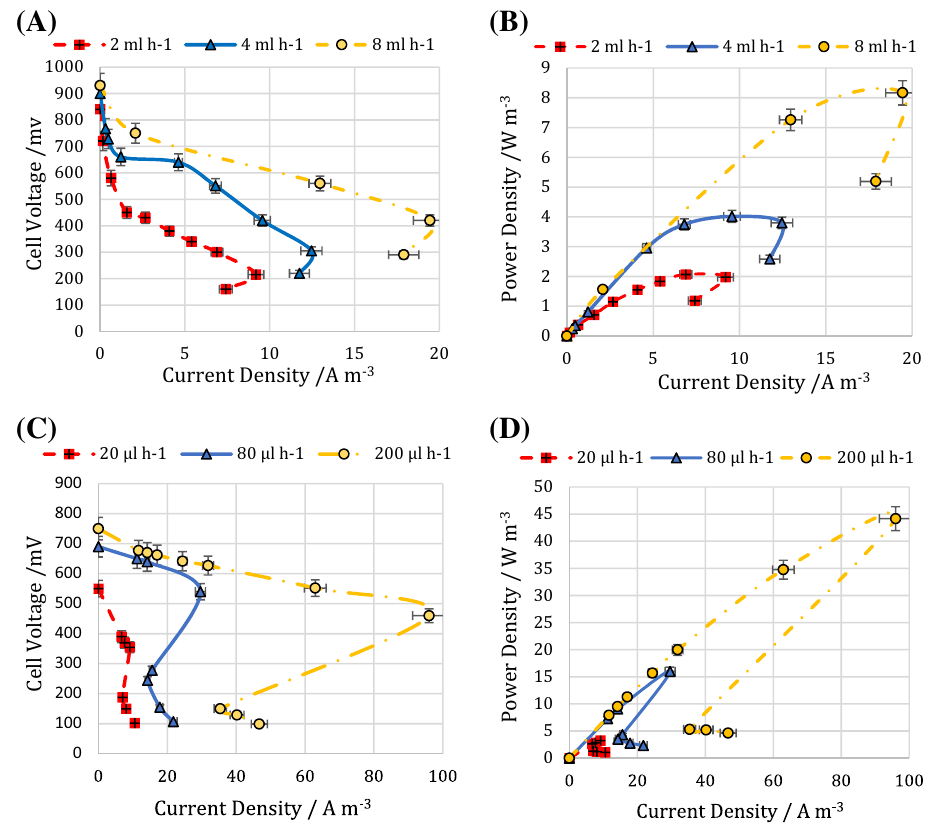
Figure 4. ( A ) polarization and ( B ) power density curves of the macro-scale MFC. ( C ) polarization and ( D ) power density curves of the micro-scale MFC. The error bars represent the variation of power and current densities among repeated